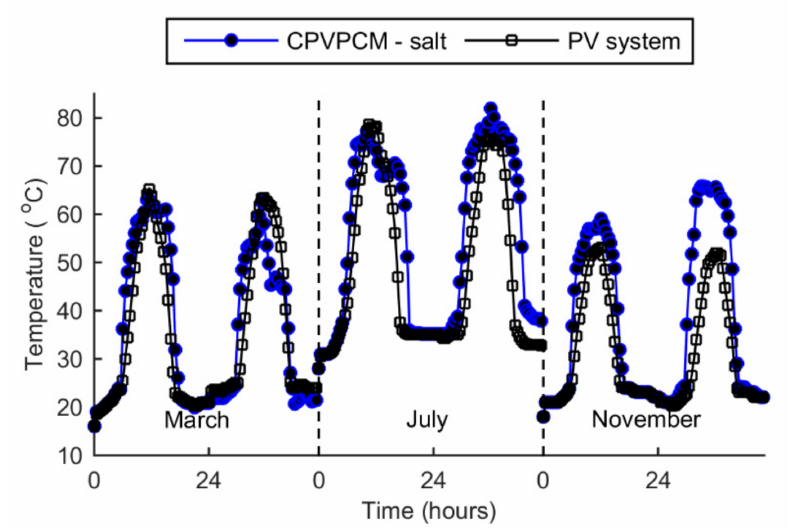
Figure 14. Comparison of temperatures of CPVPCM and PV